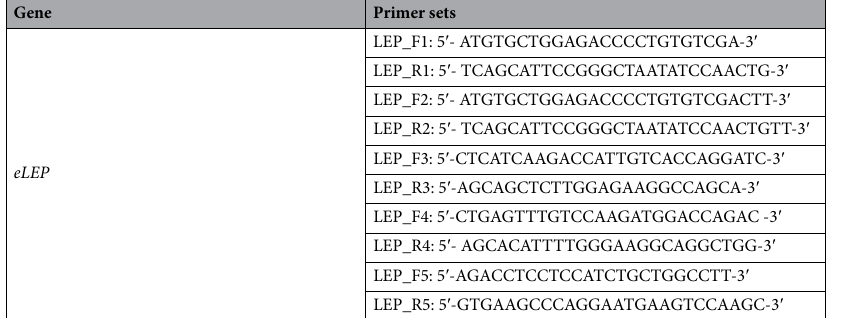
Table 2. Primers used for amplifying e Lept from emu adipose tissue*. *Because in the few avian species that have been examined, LEP expression was not found in adipose tissue, we have designed primers based on the conserved region of LEP from 6 different species (wild mallard, Japanese eel, catfish, mouse, chicken and turkey) to determine whether LEP expression can be found in emu adipose tissue.